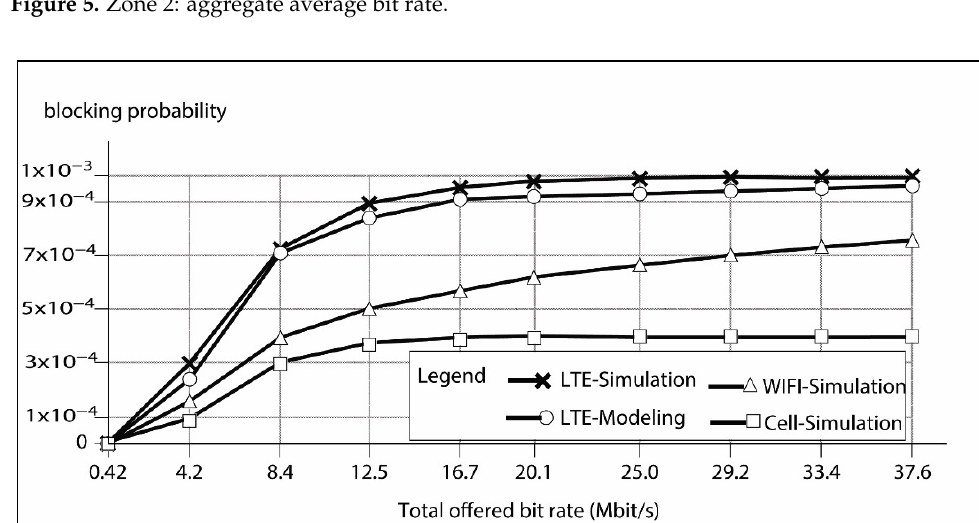
Figure 6. Blocking probability with the coexistence.